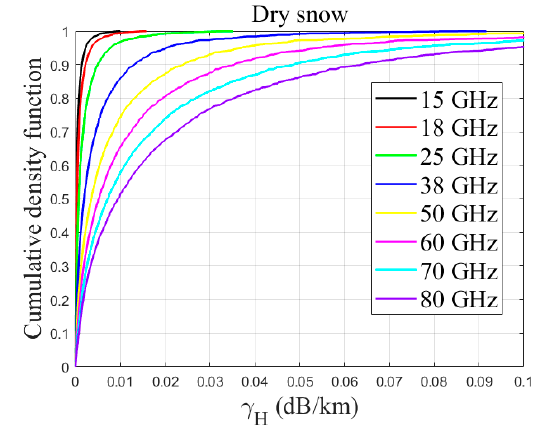
Figure 4. Cumulative density curves for the horizontal-polarization attenuation rates of dry snow at